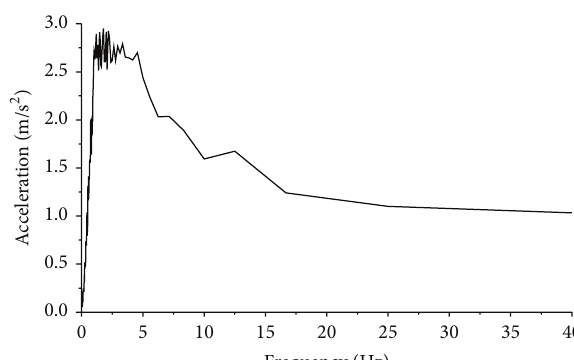
Figure 5: Acceleration response spectrum of 𝑏 1 .